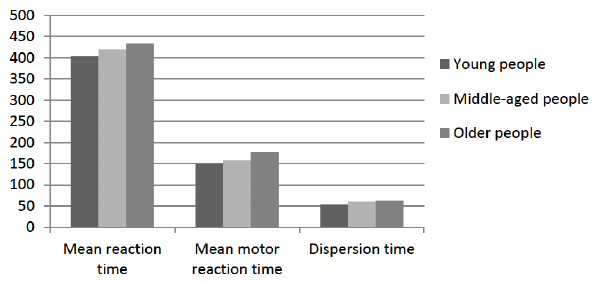
Figure 1: Mean reaction times, mean motor reaction times, disper- sion times measured by the Reaction Time Test (WST) in the three age groups, N =